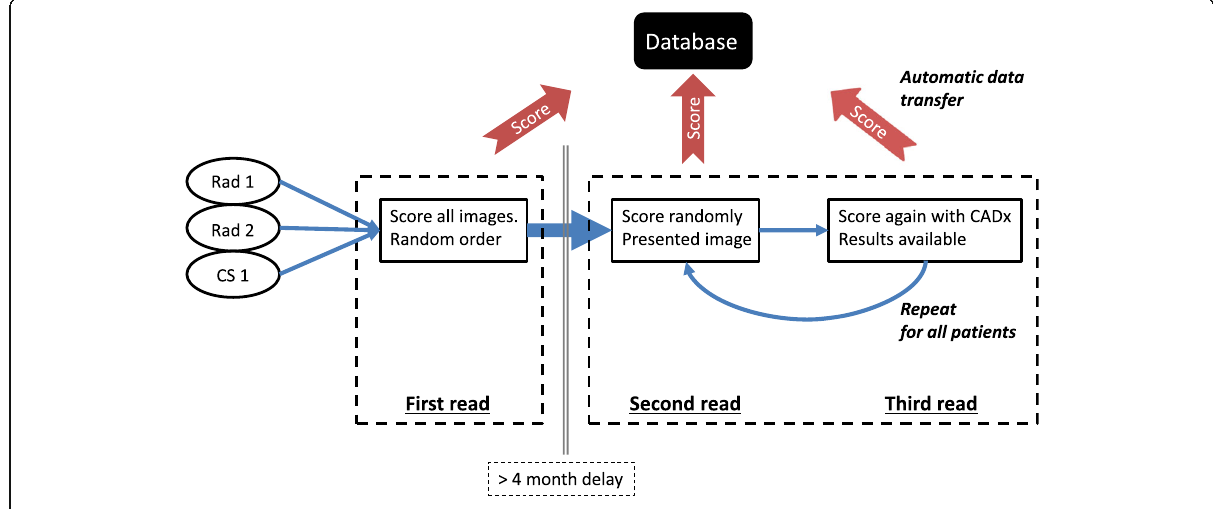
Fig. 2 Overview of study methodology. Repeated for both the local and PPMI